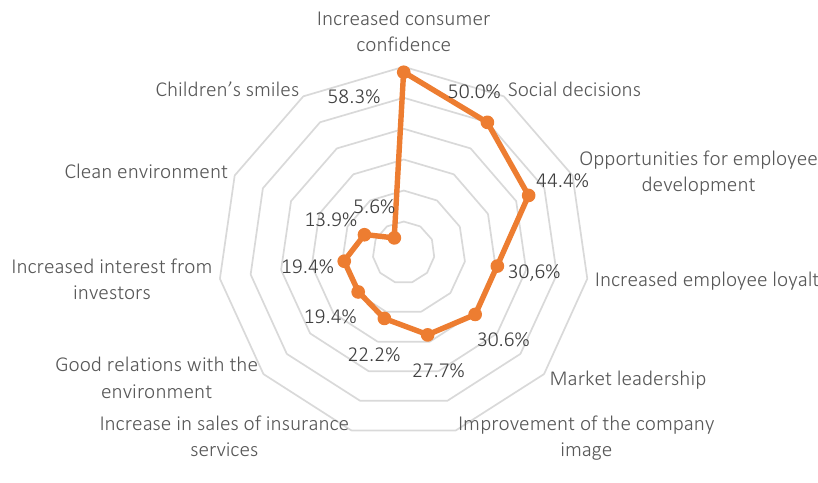
Figure 5. Advantages of taking measures related to corporate social responsibility